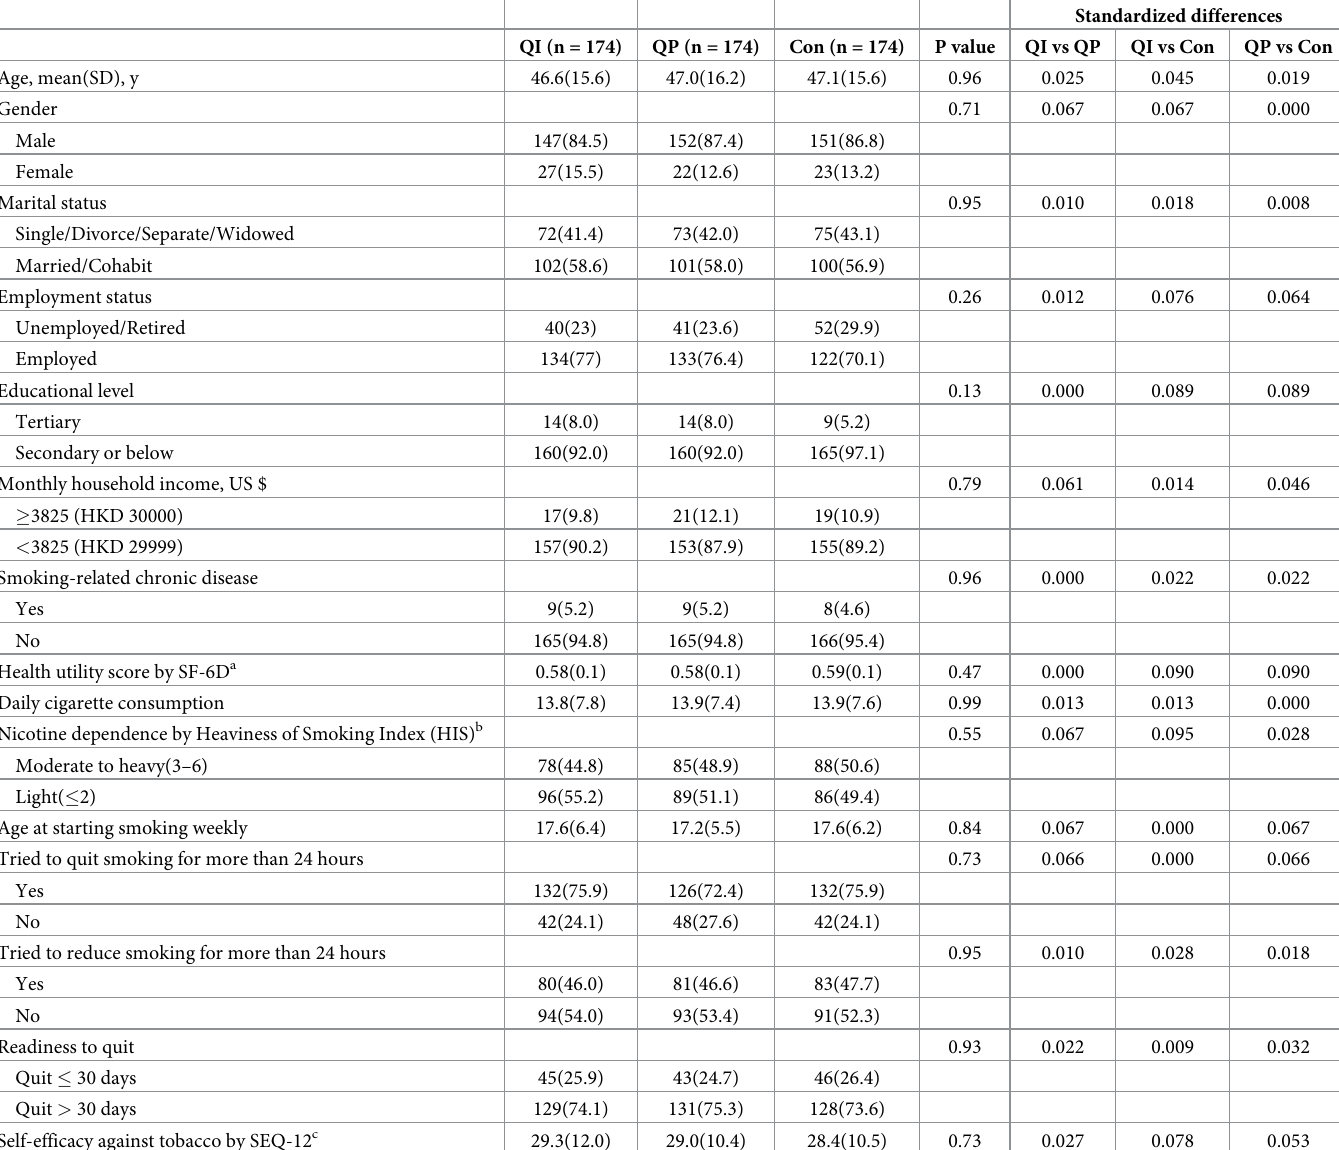
Table 2. Baseline characteristics of subjects in the Quit Immediately (QI) group, Quit Progressively (QP) group, and Control group in the propensity-score matched